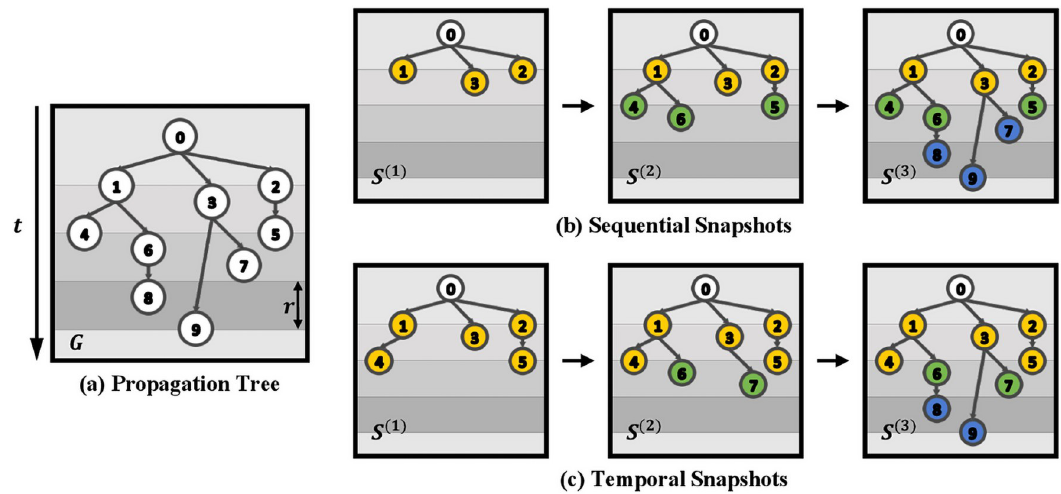
Fig 3. The disparity of snapshot generation results in sequential snapshots (b) and temporal snapshots (c) originated from the propagation tree (a). Sequential snapshots take account of chronological ordering and node counts, while temporal snapshots utilize